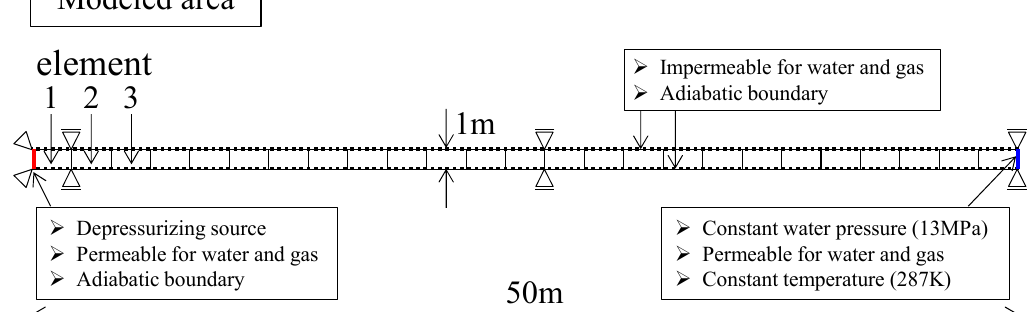
Figure 4. Simulation model and boundary conditions.